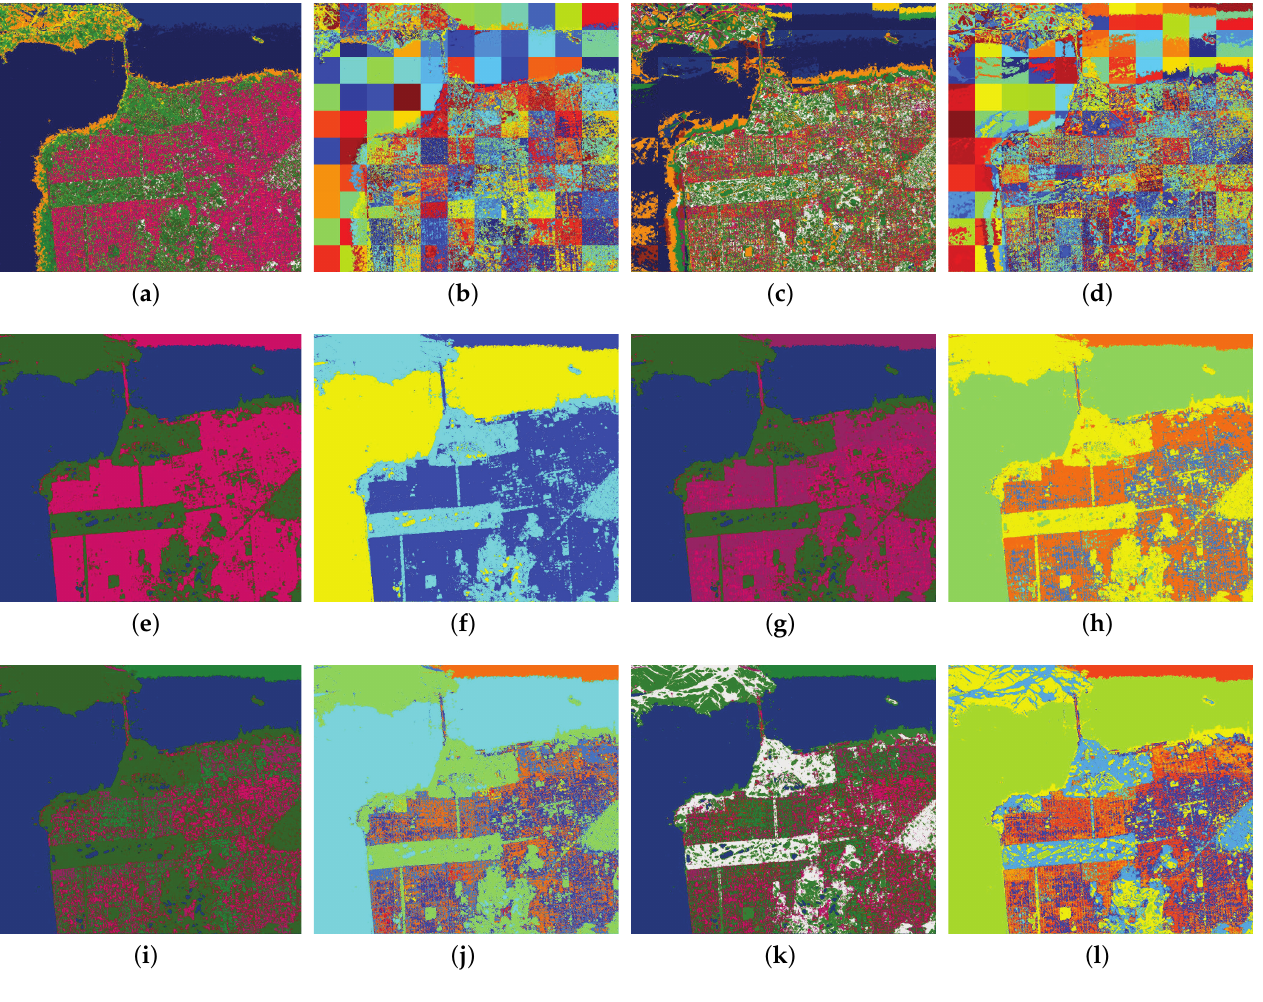
Figure 7. Classification results of San Francisco with different class numbers. ( a ) Initial results with PCST. ( b ) Initial results with “label2rgb”. ( c ) Result after optimization with PCST. ( d ) Result after optimization with “label2rgb”. ( e ) Result of 3 classes with PCST. ( f ) Result of 3 classes with “label2rgb”. ( g ) Result of 5 classes with PCST. ( h ) Result of 5 classes with “label2rgb”. ( i ) Result of 7 classes with PCST. ( j ) Result of 7 classes with “label2rgb”. ( k ) Result of 9 classes with PCST. ( l ) Result of 9 classes with